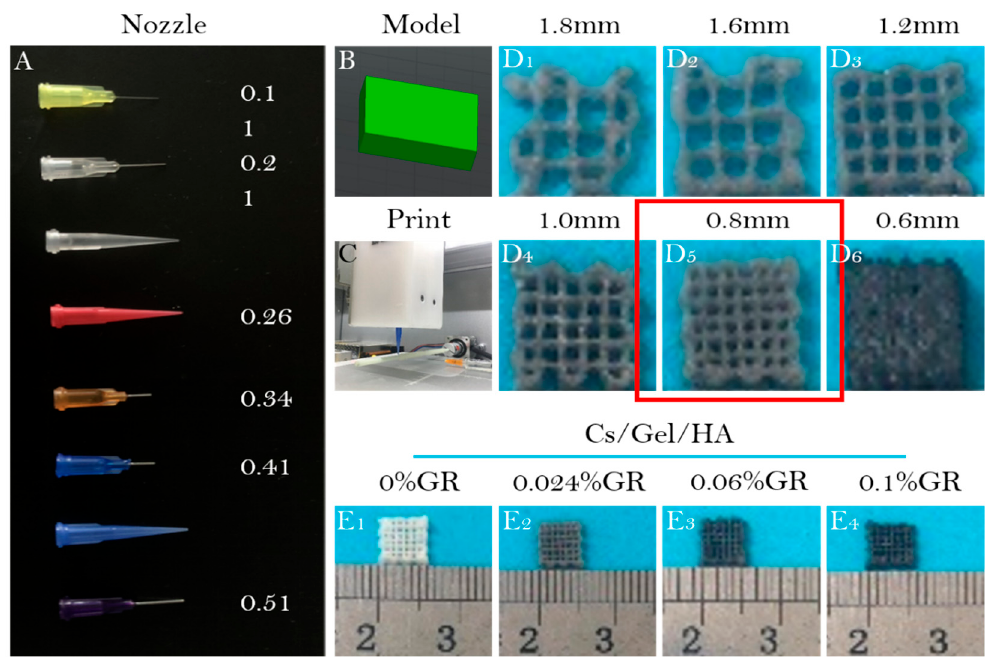
Figure 4. 3D bio-printing using bio-ink. ( A ): Needles with varying diameters; ( B ): 3D printing model of bio-sca ff old; ( C ): Images of the 3D printer; ( D 1 – D 6 ): Appearance of bio-sca ff olds with di ff erent filling distances at ( D 1 ) 1.8 mm, ( D 2 ) 1.6 mm, ( D 3 ) 1.2 mm, ( D 4 ) 1.0 mm, ( D 5 ) 0.8 mm, and ( D 6 ) 0.6 mm; Appearance of ( E 1 ) Cs / Gel / HA composite sca ff old, ( E 2 ) Cs / Gel / HA / 0.024%GR composite sca ff old, ( E 3 ) Cs / Gel / HA / 0.06%GR composite sca ff old, and ( E 4 ) Cs / Gel / HA / 0.1%GR composite sca ff